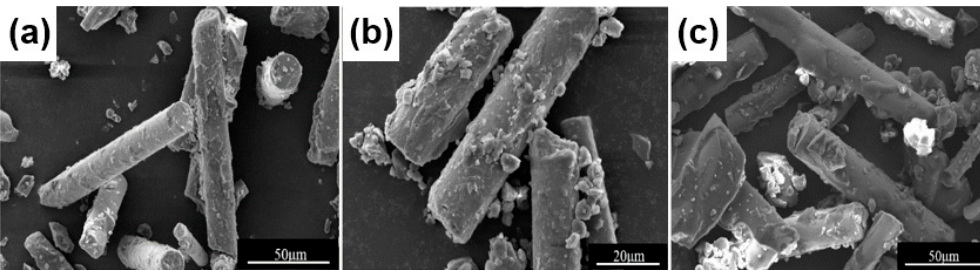
Figure 6. SEM micrographs of phenol formaldehyde resin-coated glass fibers with glass fiber contents of ( a ) 80%, ( b ) 70%, and ( c ) 60%.